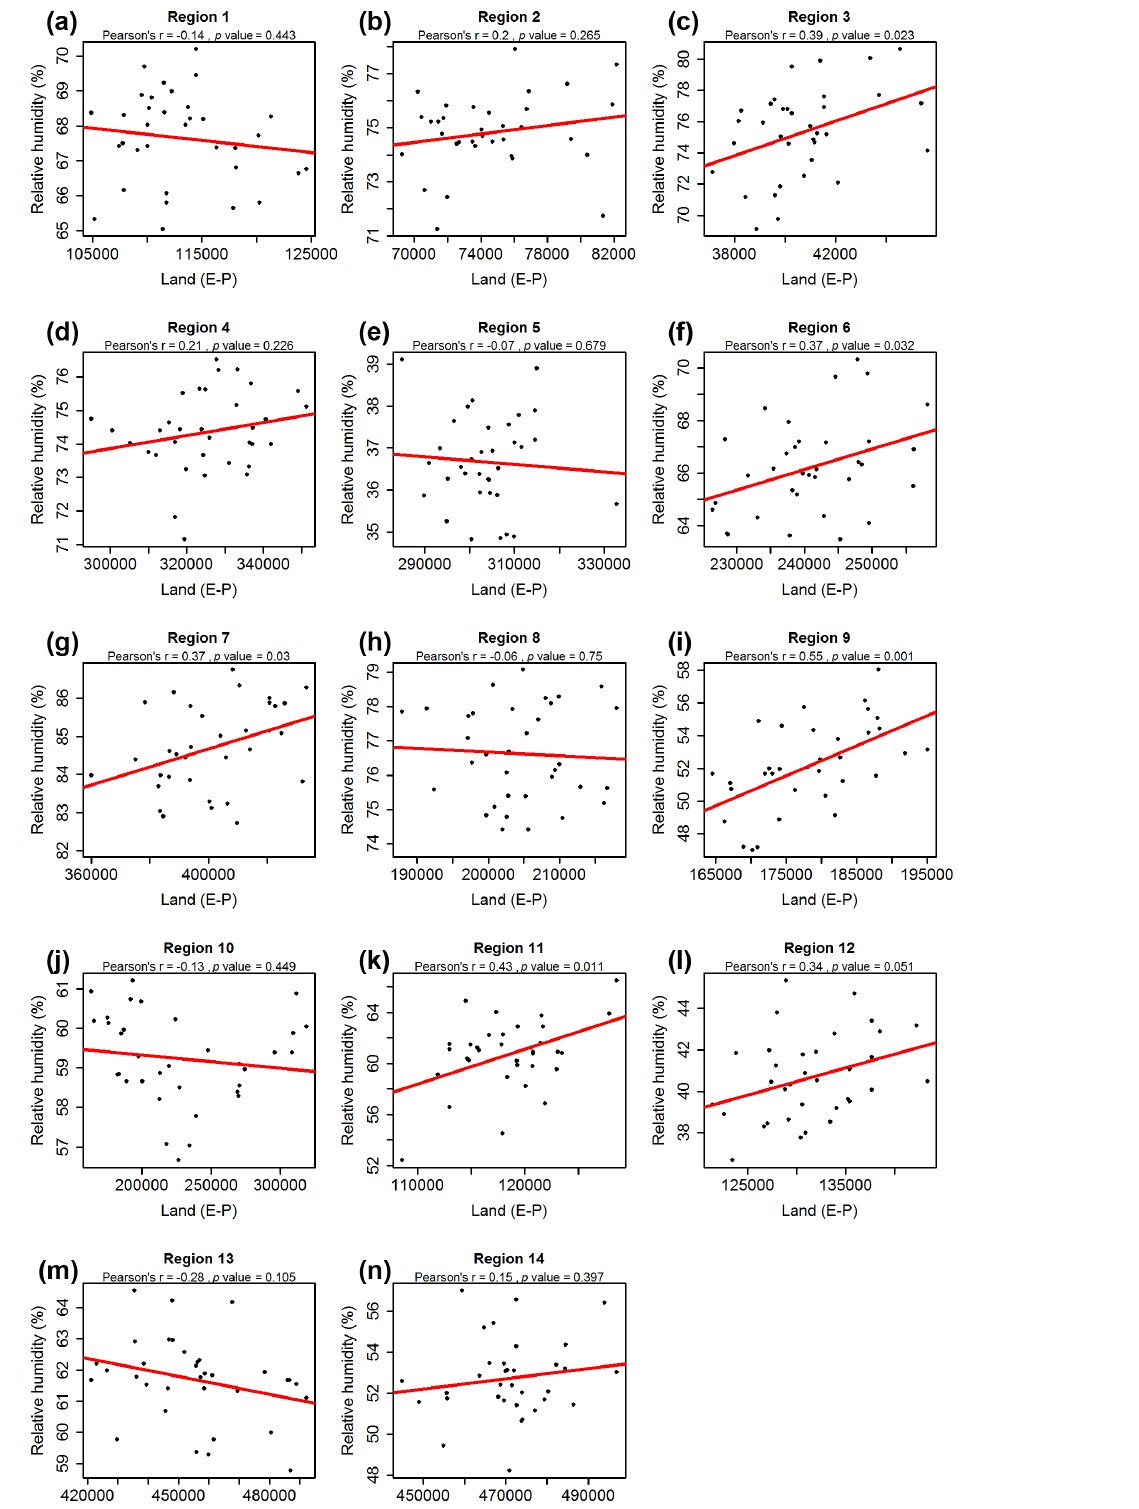
Figure 9. Relationships between the annual land contribution to annual precipitation ( E – P ) and the annual RH in the target